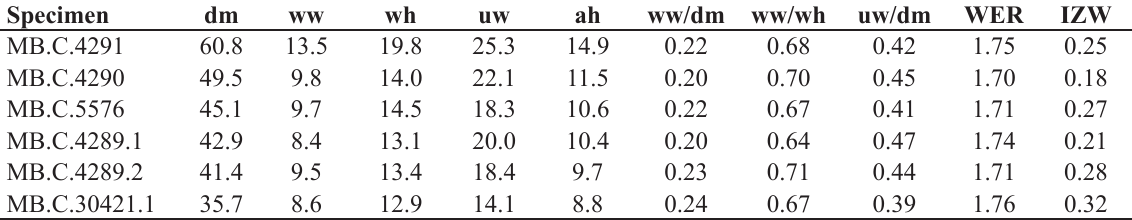
Table 3. Conch dimensions and ratios of selected specimens of Ponticeras aequabile (Beyrich, 1837).